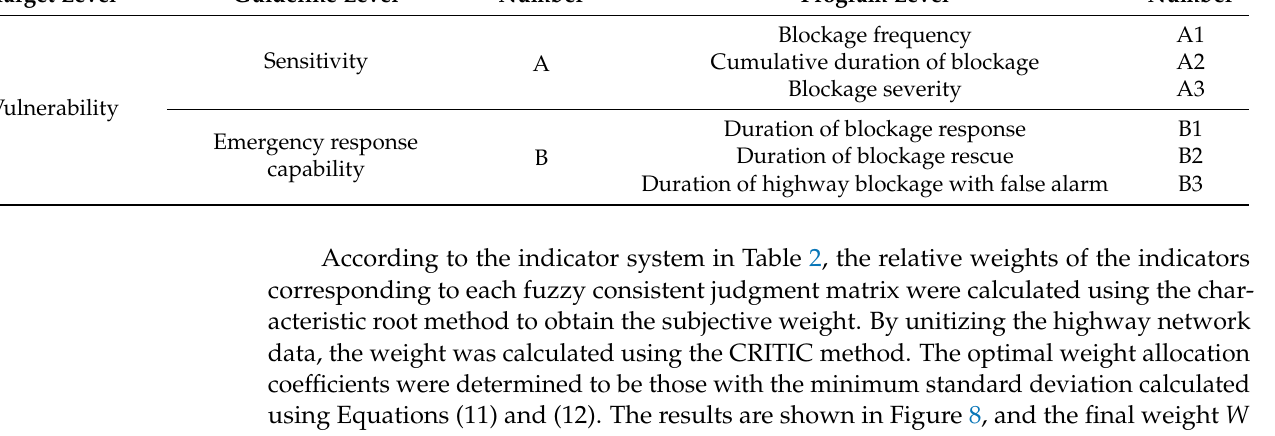
Table 2. Indicators of highway network vulnerability assessment.